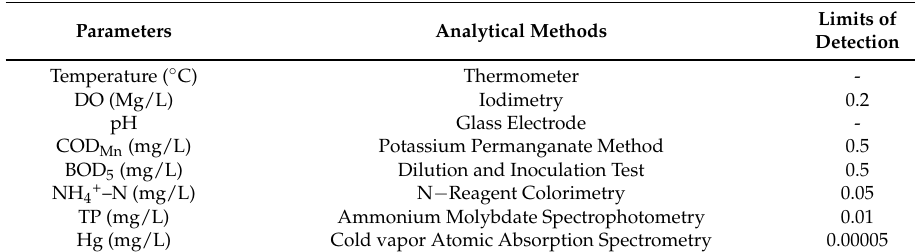
Table A1. Analytical methods for water quality parameters of the Liao River system in Liaoning province,